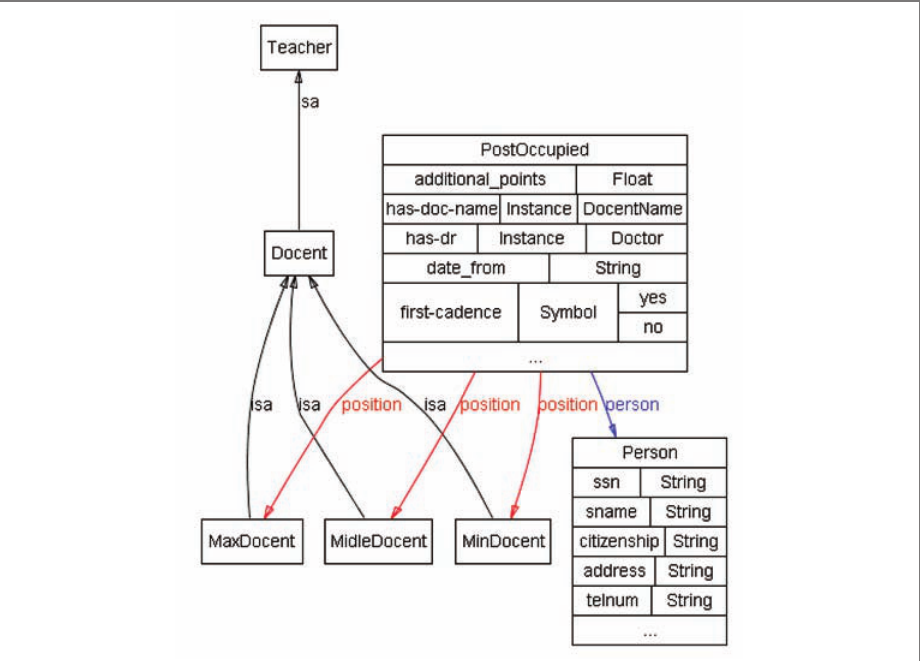
Fig. 3 . The QRT ontology presented using Ontoviz plug-in (Sintek 2007)